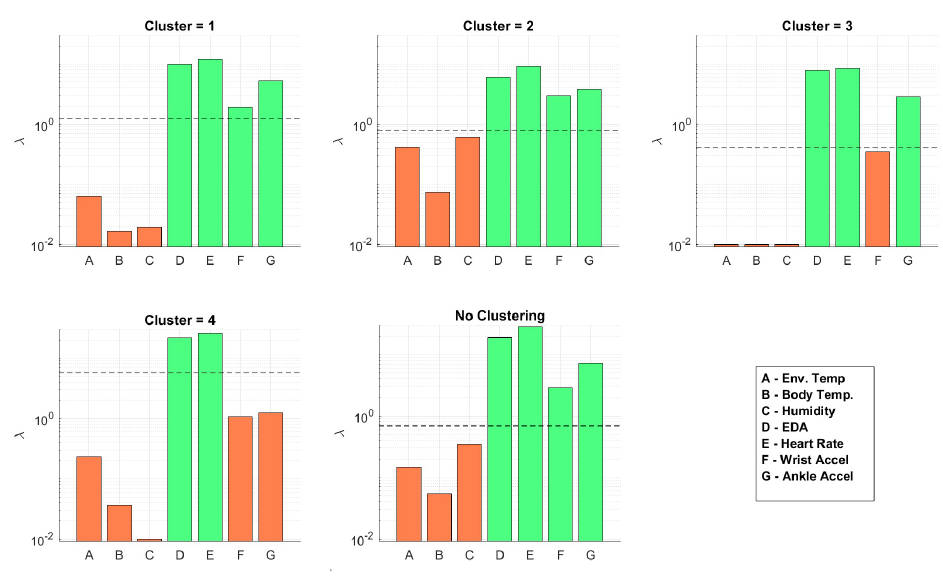
Figure 5. λ -levels at which sensors are excluded and included in the model for each cluster as well as without